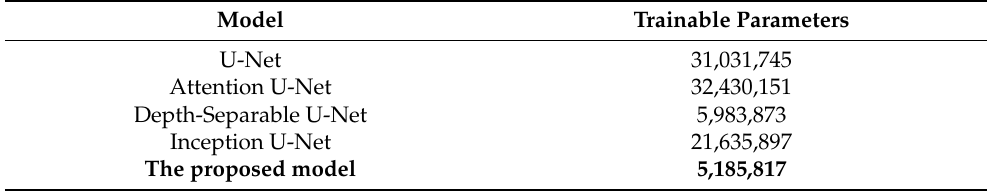
Table 1. Comparisons of the Number of Trainable Parameters for the Segmentation Models.